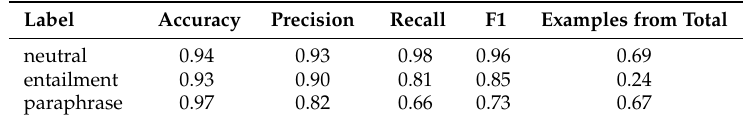
Table 2. ASSIN-PTPT NLI results per class, for the fine tuned ptBERT-Large model.